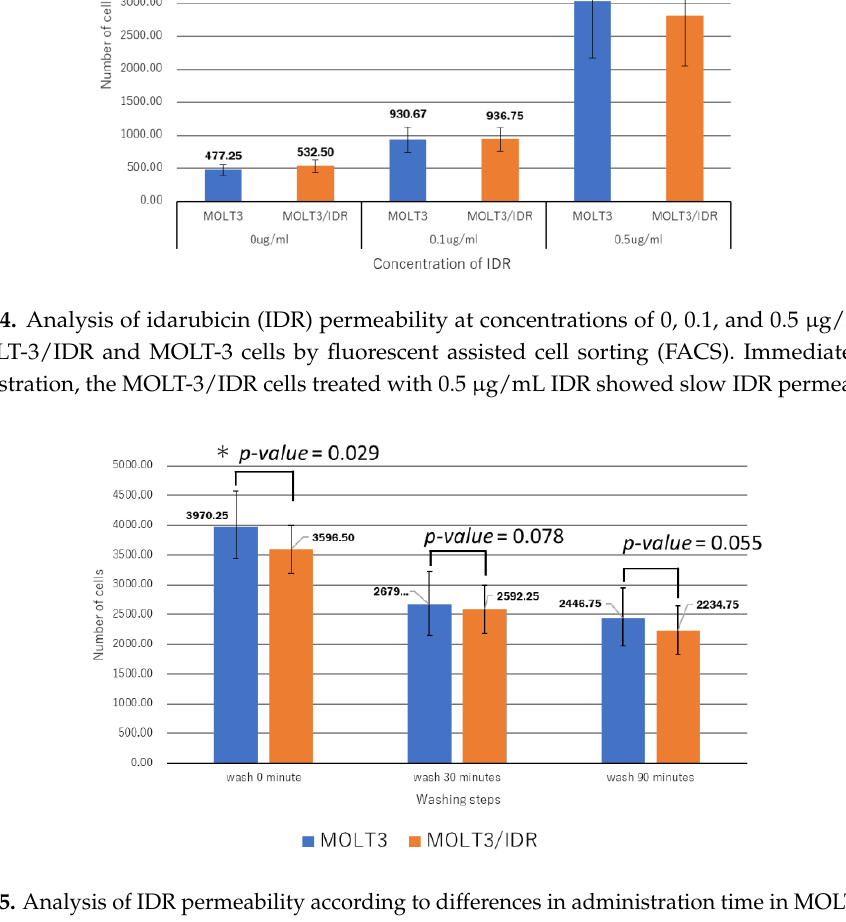
Figure 5. Analysis of IDR permeability according to differences in administration time in MOLT-3/IDR and MOLT-3 cells by FACS. After 0, 30, and 90 min incubation of MOLT-3/IDR cells with 0.5 µ g/mL IDR, the permeability was slightly slower. In particular, IDR permeability at 0 min after washing was the slowest in MOLT-3/IDR cells ( t -test, p -value = 0.029; p -value < 0.05, t -test).